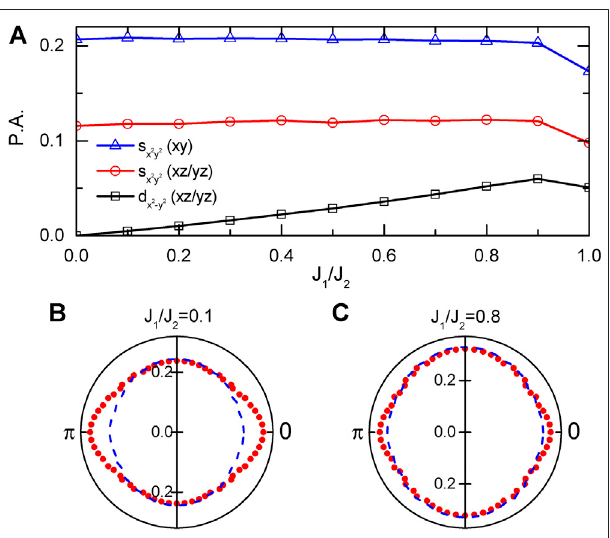
FIGURE5|(A) Evolutionoftheleadingpairingchannelswith J 1 / J 2 inthe multiorbital t-J model for electron doped NaFeAs. All the channels have the A 1 g symmetry. P.A. denotes pairing amplitude. (B) , (C) Angular dependence of the superconducting gaps (red circles) along the electron pocket centered at ( π , 0 ) in the same model at J 1 / J 2 (cid:2) 0 . 1 [in (B) ] and J 1 / J 2 (cid:2) 0 . 8 [in (C) ], respectively. The blue dashed line is a fi t to the single parameter gap function Δ 0 cos k x cos k y . The deviation from this fi t implies a multigap structure arising from the orbital-selective pairing, adapted from